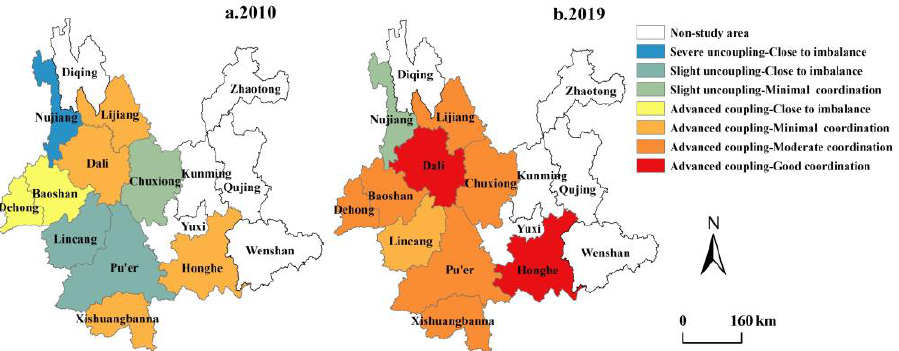
Figure 7. The spatial combination of coupling degree and coupling coordination degree of tourism industry and urbanization.